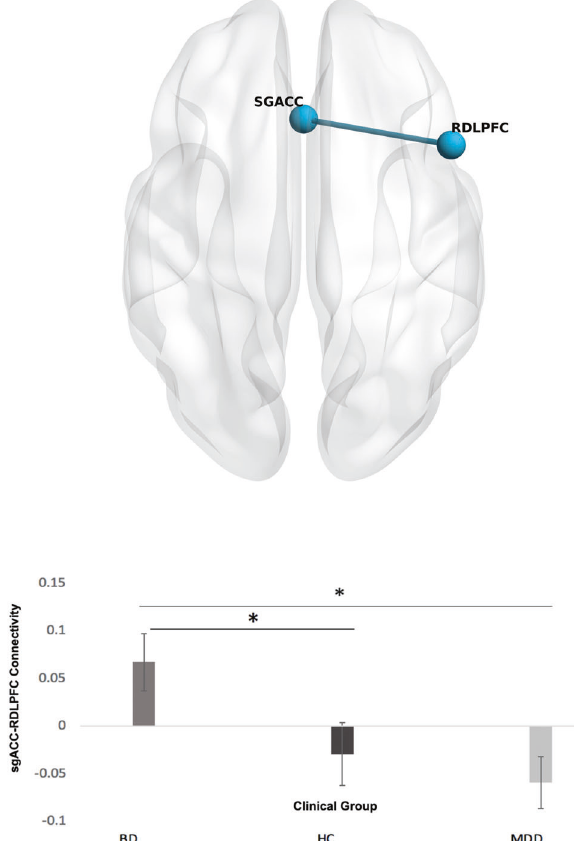
Fig. 1 Connectivity differences between BD and MDD patient groups, and control group in seed-based analyses. The results from the seed-based analyses indicated signi fi cantly greater connectivity between the sgACC-RDLPFC during rest, in the BD group relative to MDD and controls. The graph below illustrates the differences in connectivity for the sgACC-RDLPFC across the three groups. * p <